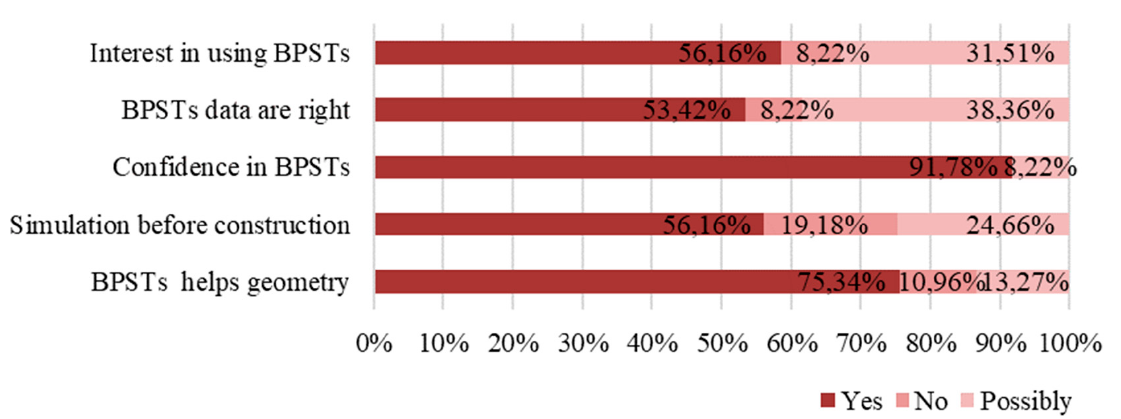
Figure 1. Confidence parameters of architects with professional experience below 5 years.